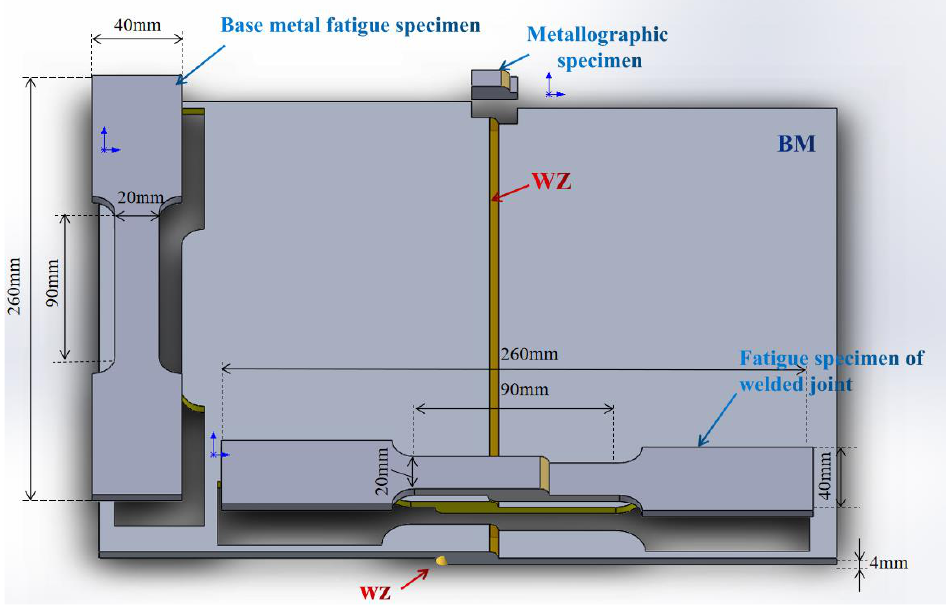
Figure 1. Fatigue and Metallographic (hardness) Samples.